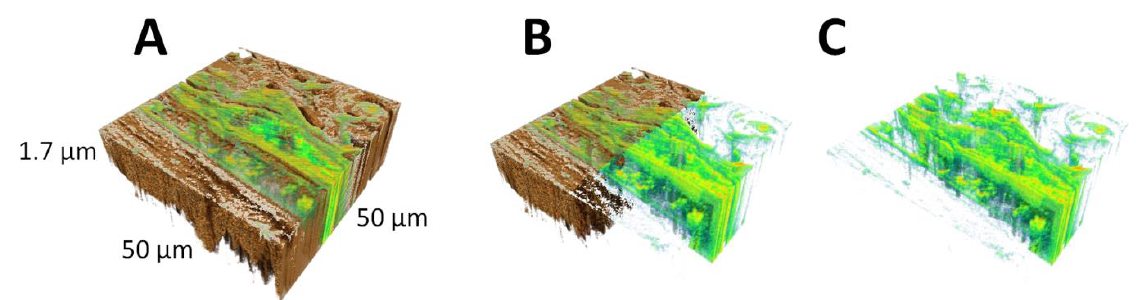
Figure 7. 3D-visualisation of cup-plant particle–particle bondlines, TOF SIMS data reconstructed by the ORS software (Object Research Systems, QC, Canada); ( A , B ) cup-plant PB with visible particle–particle bondline, and ( C ) the pMDI bondline imaging (Q/m 26).